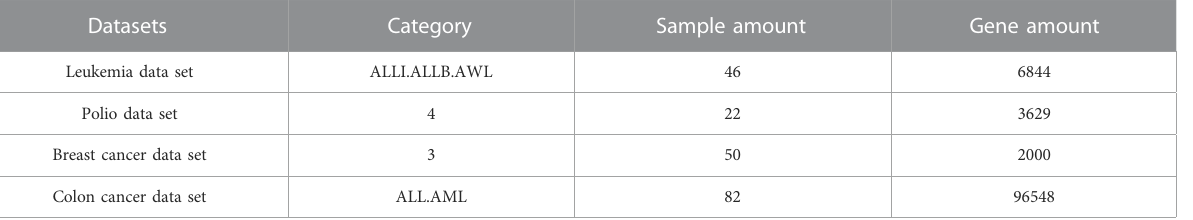
TABLE 1 Sample gene datasets.